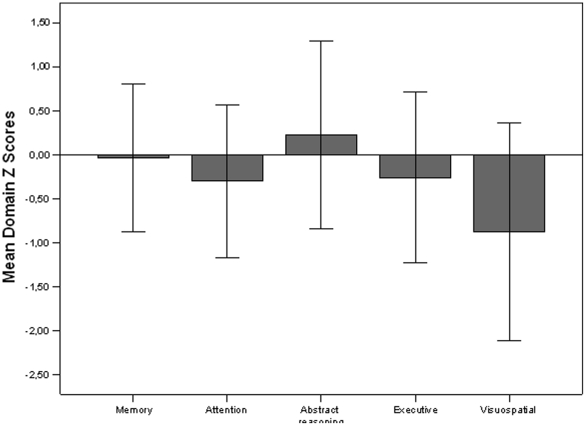
Distribution of neurocognitive impairment, expressed as MDZ scores±SD, in the patients enrolled (Memory MDZ −0.03±0.84, attention MDZ −0.3±0.87, abstract reasoning 0.23±1.1, executive MDZ −0.26±0.97, visuospatial MDZ −0.87±1.24).